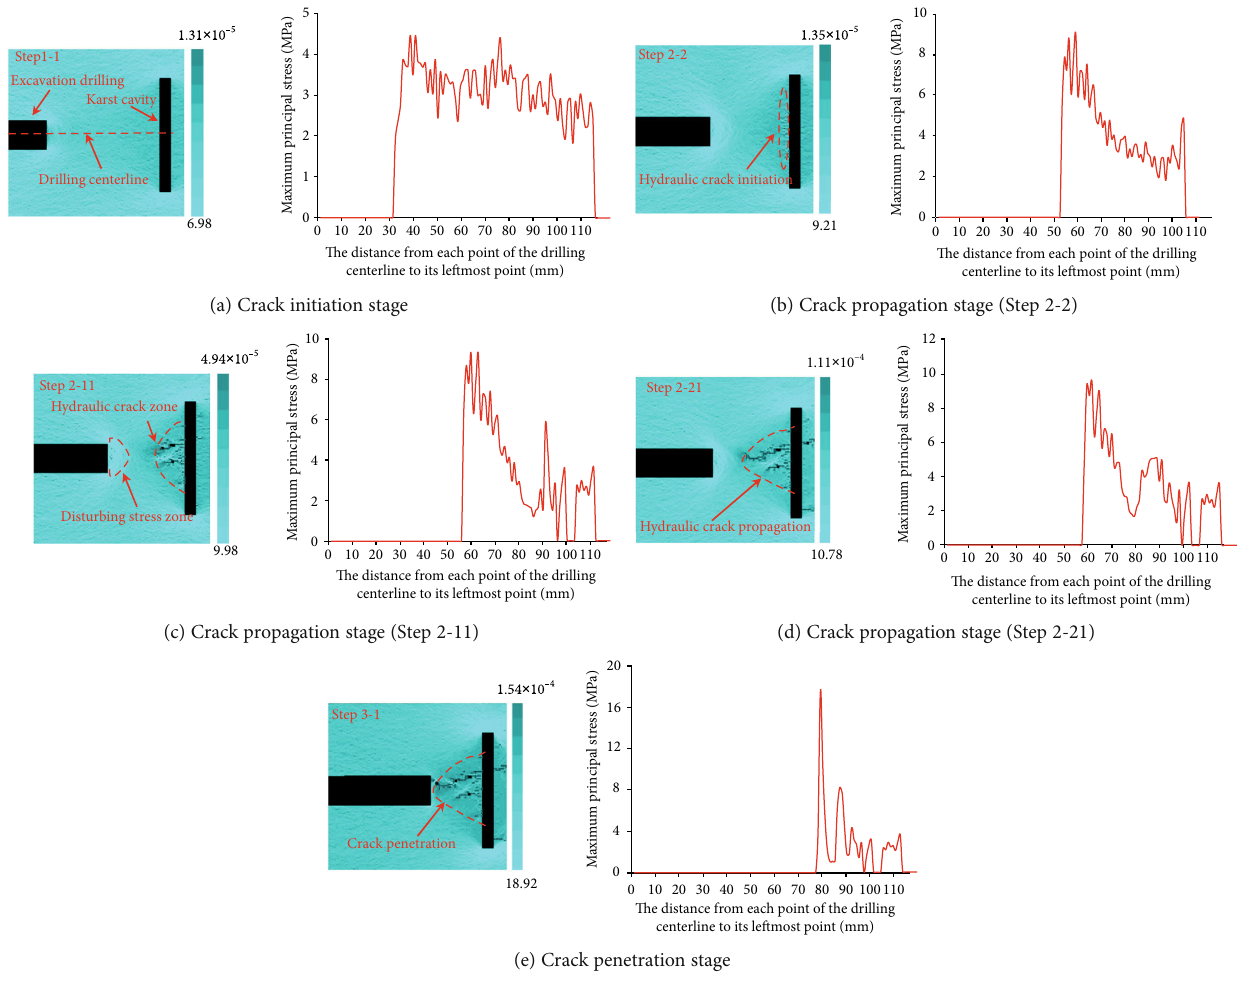
Figure 5: The maximum principal stress